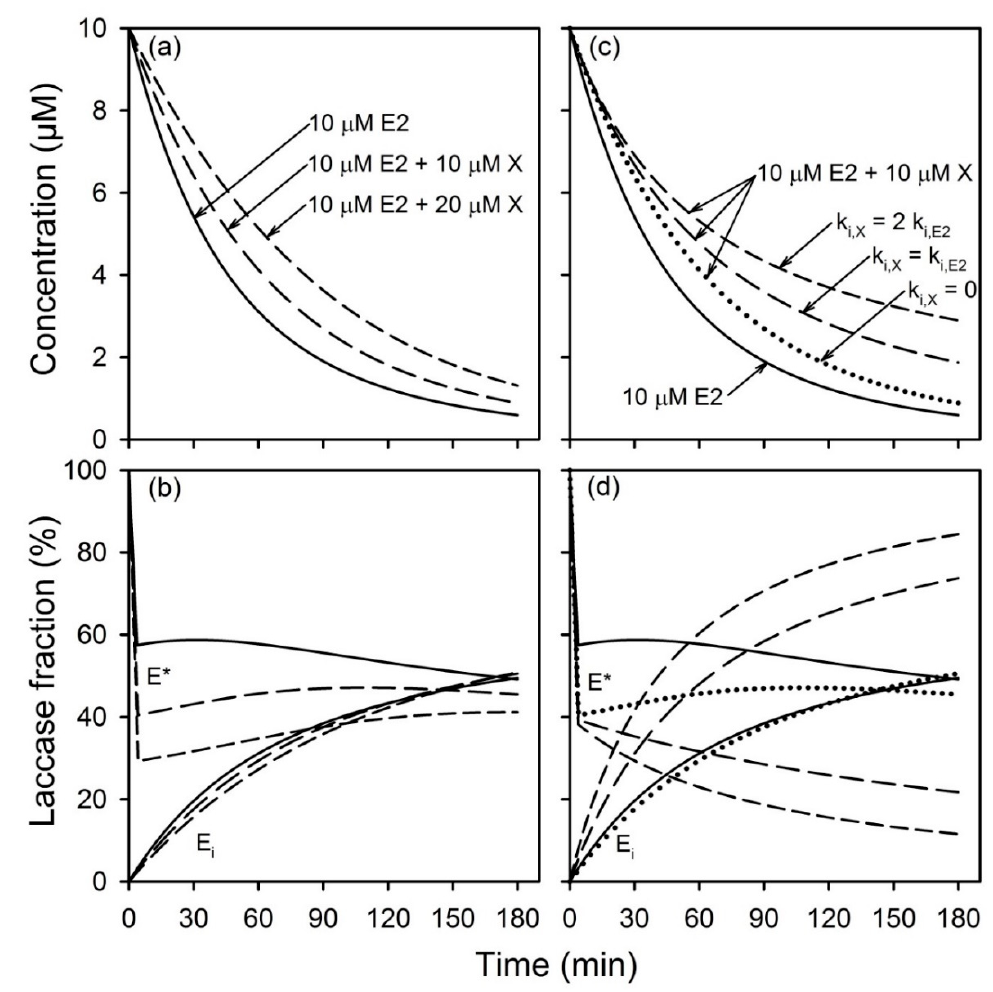
Figure A3. Predicted impacts of a hypothetical secondary substrate, X, on the kinetics of oxidation of the target substrate, estradiol (E2), and the corresponding fractions of laccase in the oxidized, E*, and inactivated, E i , states over time: ( a,b ) effect of varying the initial concentration, [S X ] 0 , of the secondary substrate, X, when it is non-inactivating (i.e., k i = 0); ( c,d ) effect of varying the inactivation rate constant, k i , of the secondary substrate, X, for a fixed initial secondary substrate concentration, [S X ] 0 , of 10 µ M. For all simulations, the initial concentration of the target substrate was 10 µ M and the total enzyme supplied to the reaction, [E t ] , was 3.64 nM. The fractions of enzyme in the E*and E i states over time are expressed as a percentage of the total enzyme, [E t ] . The fraction of enzyme in the native state, E, is not shown.